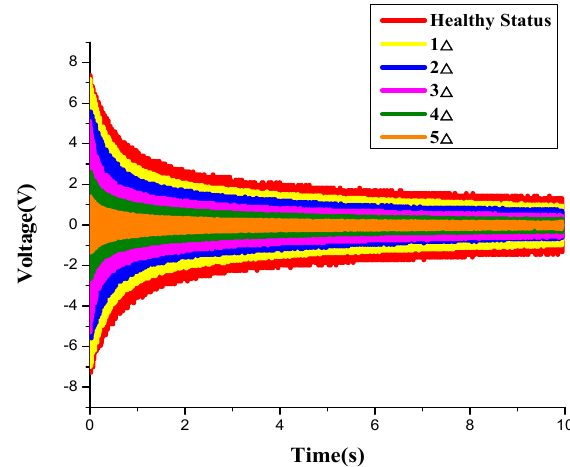
Figure 19. The variation of voltage value of the smart aggregates (SAs) under different damage states.